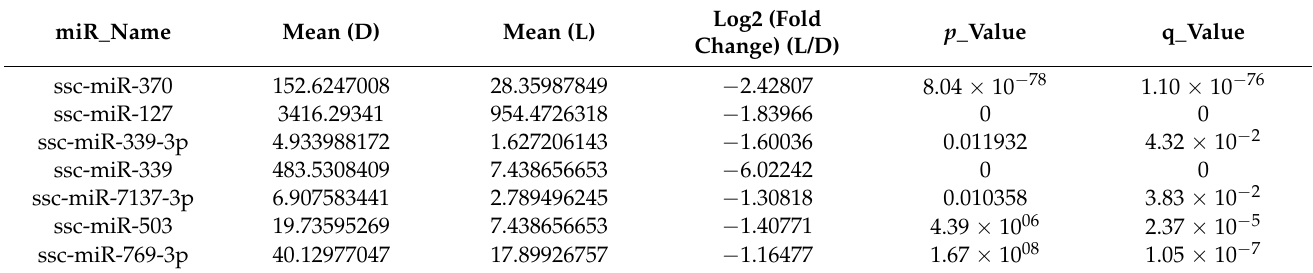
Table 1. Differentially expressed miRNAs in the IMF tissues of Large White and Laiwu pigs.